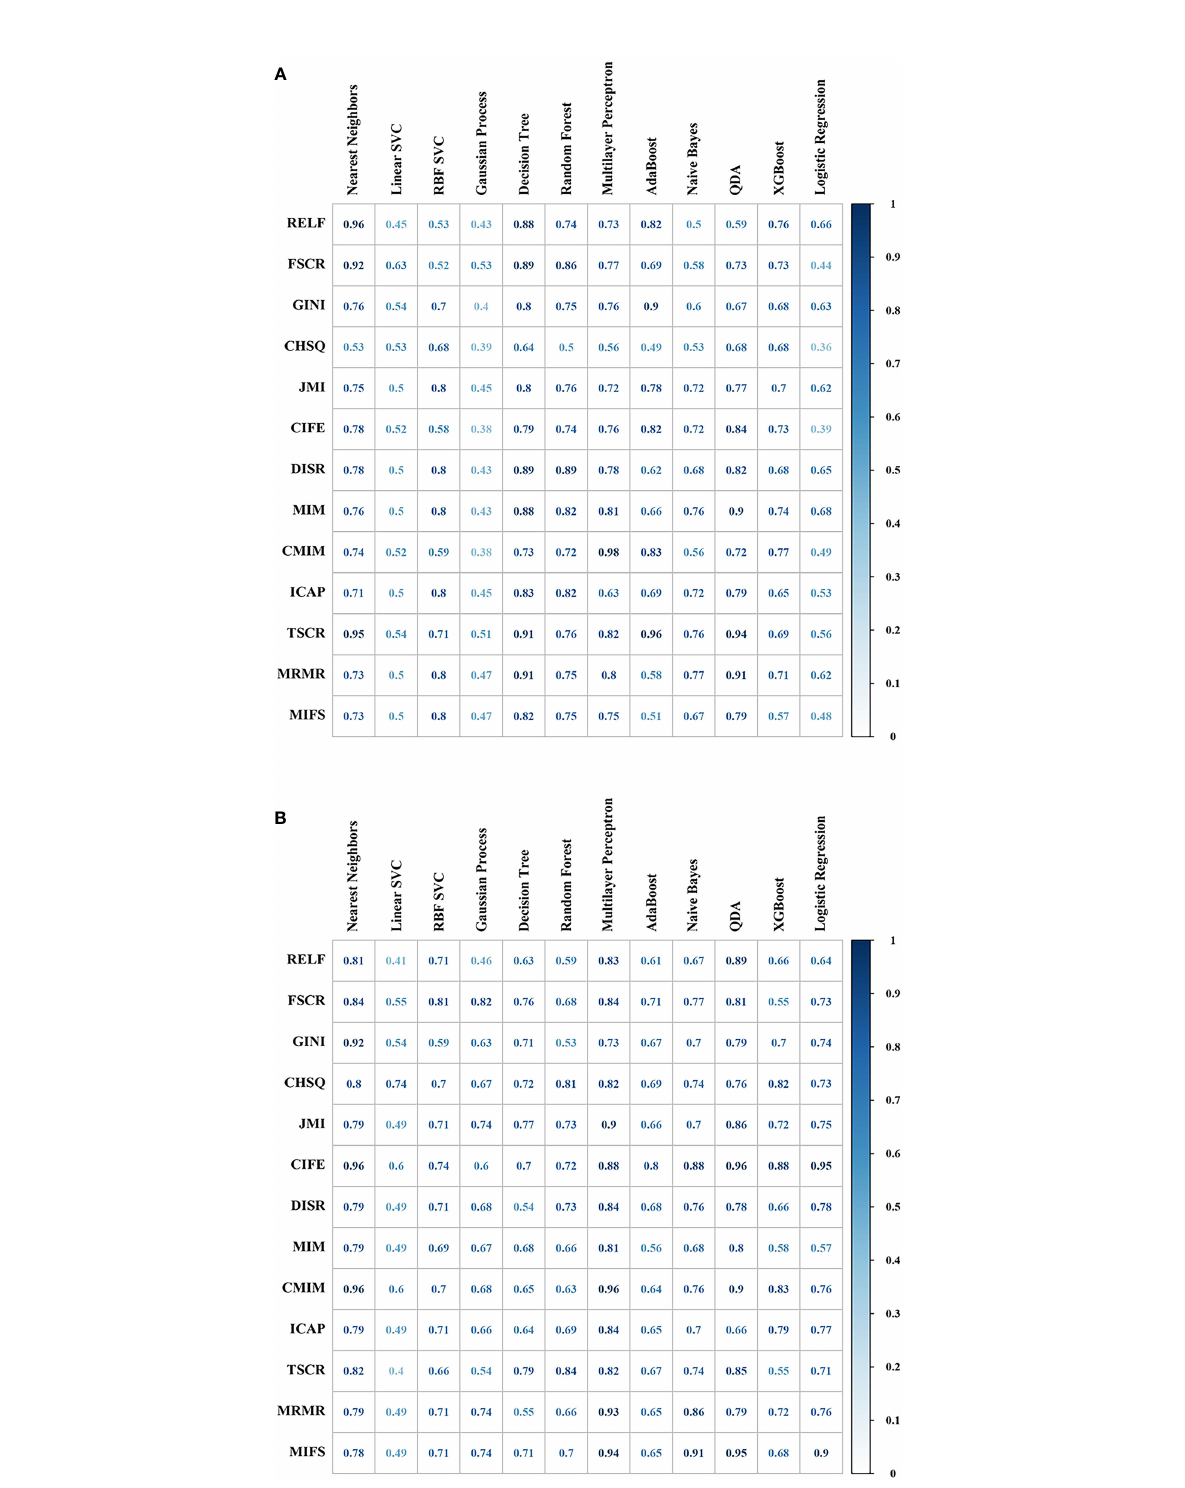
FIGURE 4 The predictive performance (area under the curve, AUC) of different combinations of feature selection methods (rows) and classi fi cation algorithms (columns) were presented in the heatmap. (A) Cross-validated AUC values of 156 models with InceptionV3 features. (B) Cross- validated AUC values of 156 models with radiomics